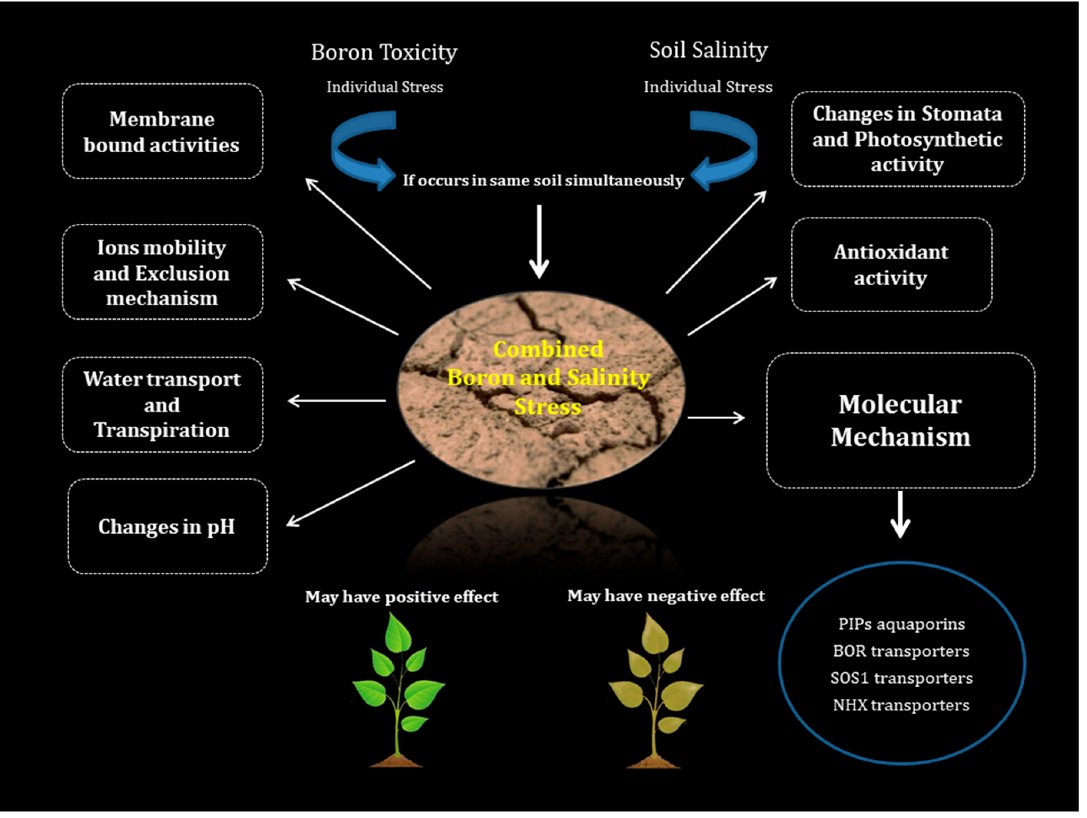
Figure 1. Different mechanisms involved in increasing the tolerance or the susceptibility of plants towards combined B toxicity and salinity stress condition.